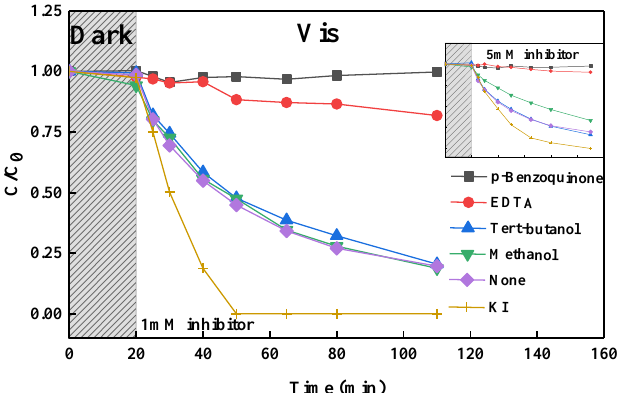
Figure 9. The relationship between C/C 0 and t of the effect of the inhibitor on the photocatalytic activity of rGO – P25 photocatalyst. (visible wavelength 420 nm, 10 tubes, catalyst concentration 0.5 g/L, initial concentration of BPA 0.01 mol/mL, inhibitor concentration is 1 mol/mL, solution volume is 100 mL).